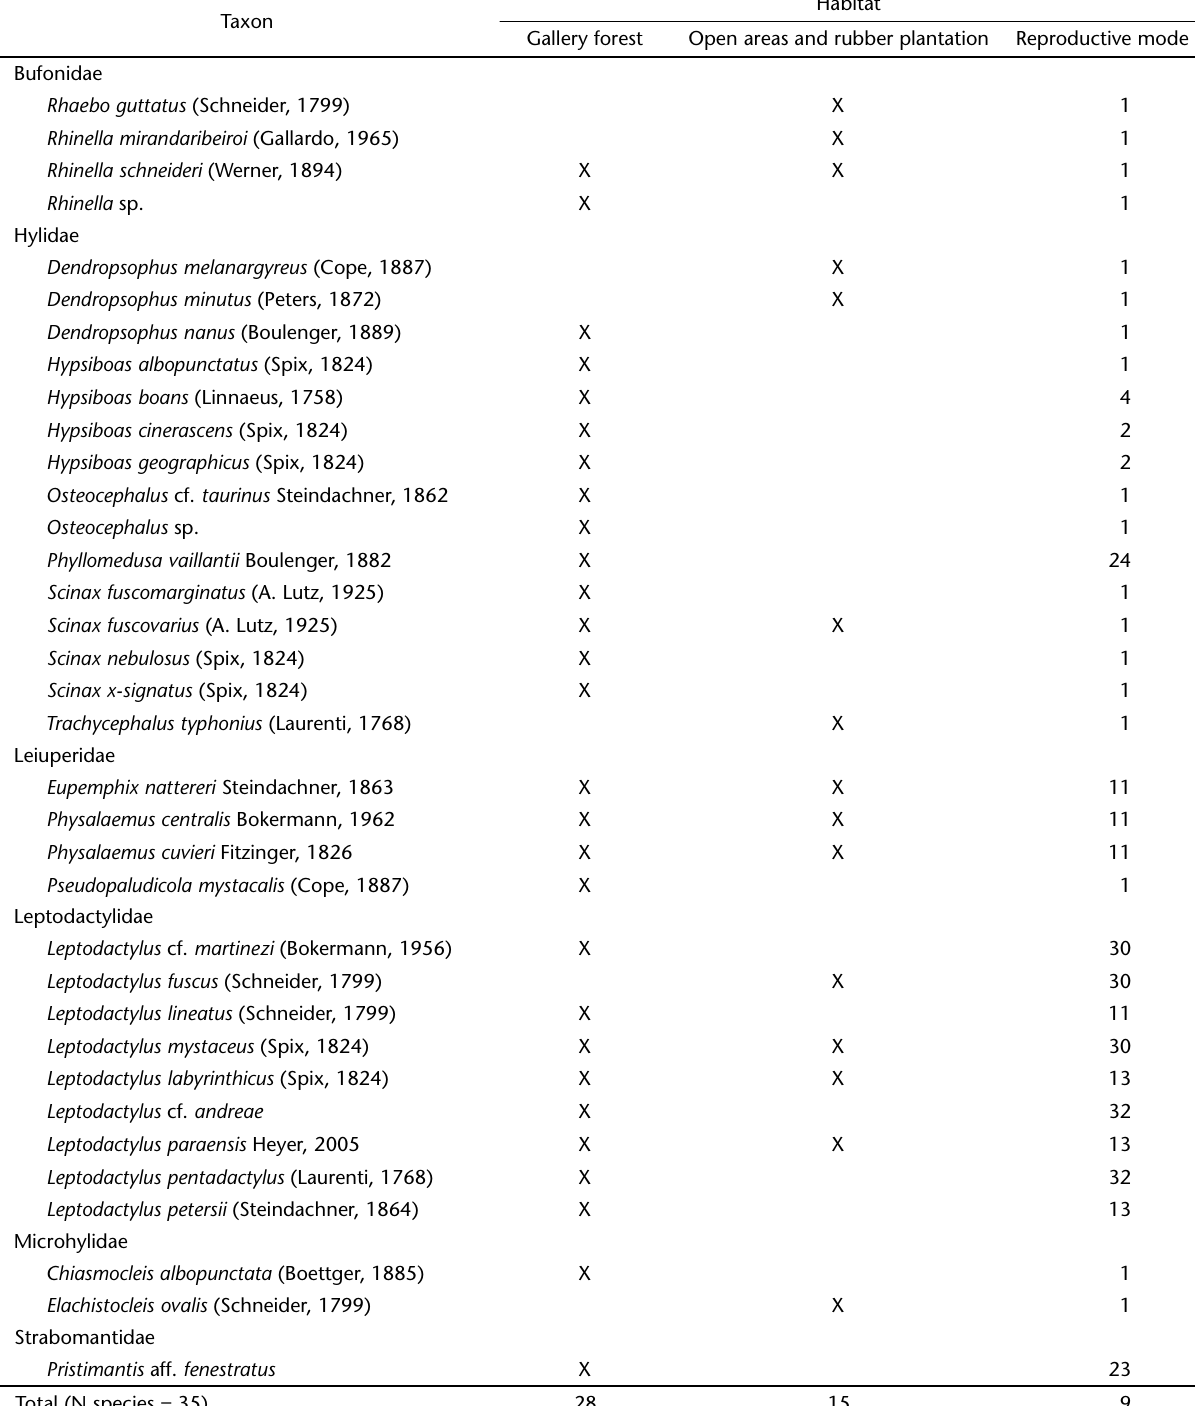
Table II. Anuran species recorded in the present study at the Tanguro farm in Mato Grosso, the habitats in which they were found, and their reproductive modes. Habitat Taxon Gallery forest Open areas and rubber plantation Reproductive